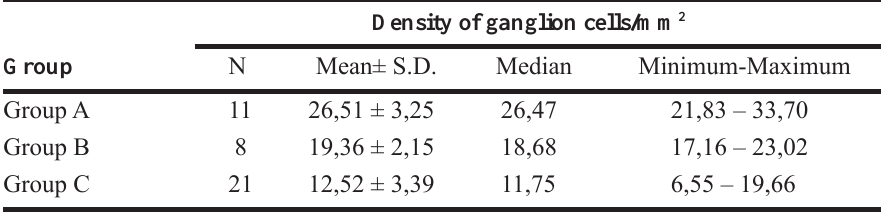
TABLE 2 - Description of the variable “Density of ganglion cells” in groups A, B e C